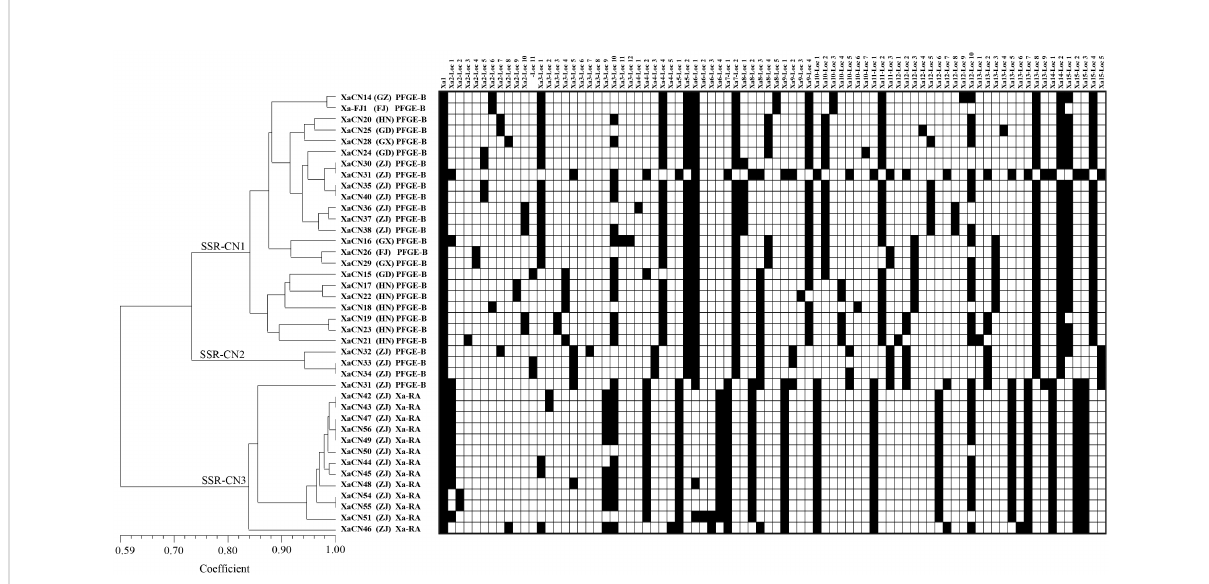
FIGURE 2 UPGMA phylogenetic tree of 40 strains of Xanthomonas albilineans from China based on 15 SSR marker loci (model = Maximum Composite Likelihood).